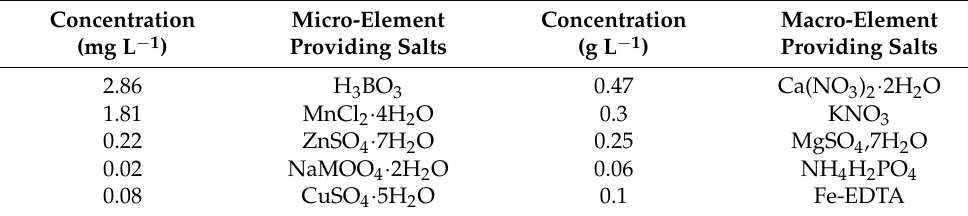
Table 1. Modified Hogland-based formulation used as a basal nutritional solution